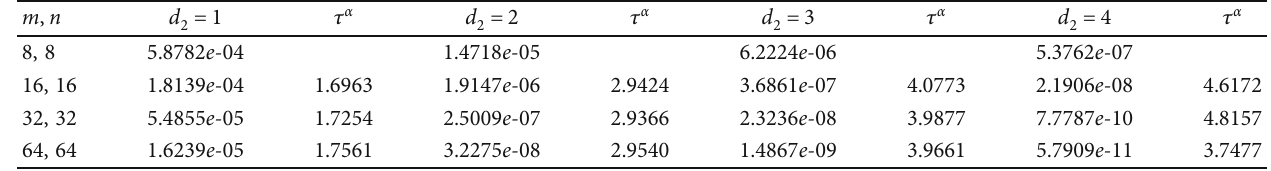
= 7 at t = 1 for equidistant 1